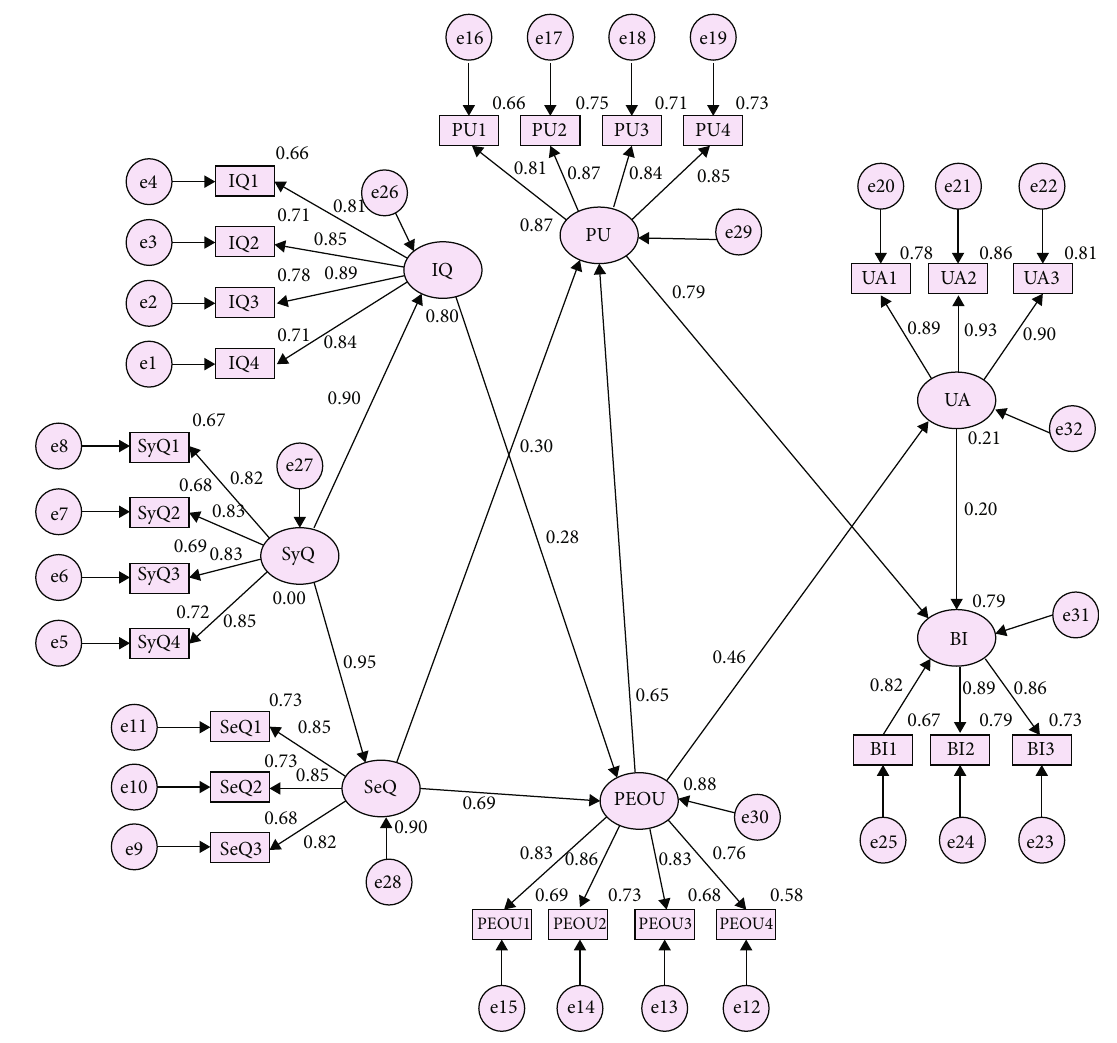
Figure 2: Modi fi ed structural equation